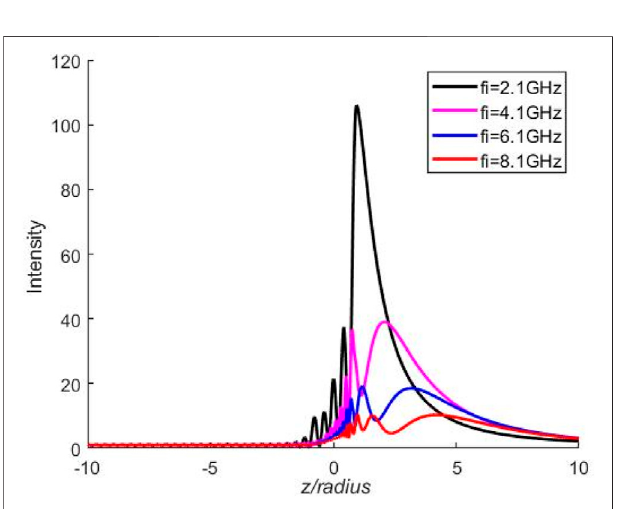
FIGURE9| Thein fl uenceofdifferentincidentfrequenciesoninternaland near-external fi elds at f p = 2 GHz and ] c = 50